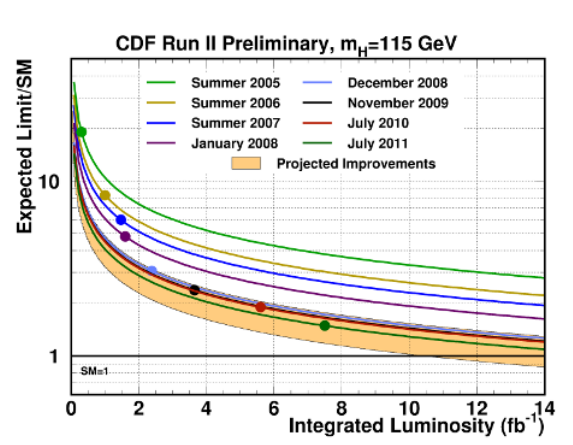
Fig. 6. Plausible scenario of the analysis improvements that can be finalized by the CDF collaboration (similar results are ex- pected from D0) for the Winter 2012 conferences where the full dataset of 10 fb − 1 will be